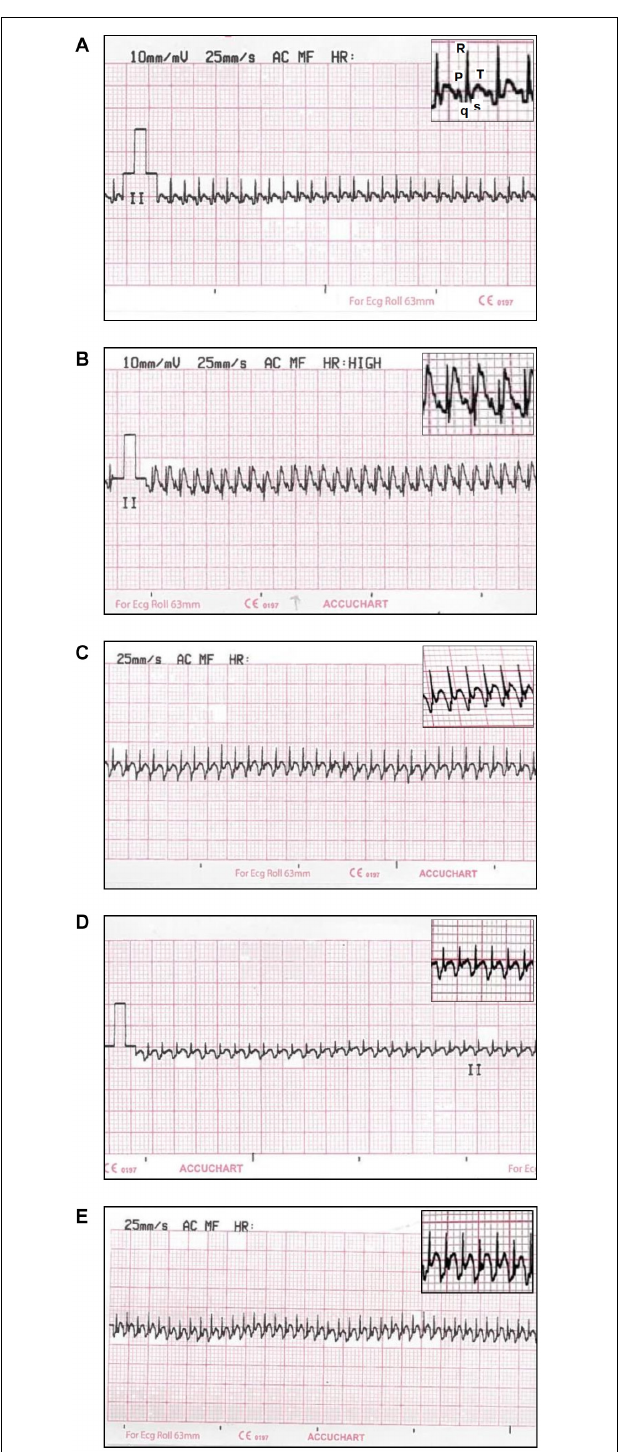
FIGURE 3 | Electrocardiogram (ECG) traces (Lead II) recorded from: (A) controls showing regular ECG pattern with defined P, QRS, and T waves; (B) ISO-induced MI showing ST-segment elevation; (C) lipoic pre-treated rats showing a marked decrease in ST-segment elevation; (D) zinc pre-treated rats showing a marked decrease in ST-segment elevation and R wave amplitude; (E) clopidogrel pre-treated rats showing a decrease in ST-segment elevation.